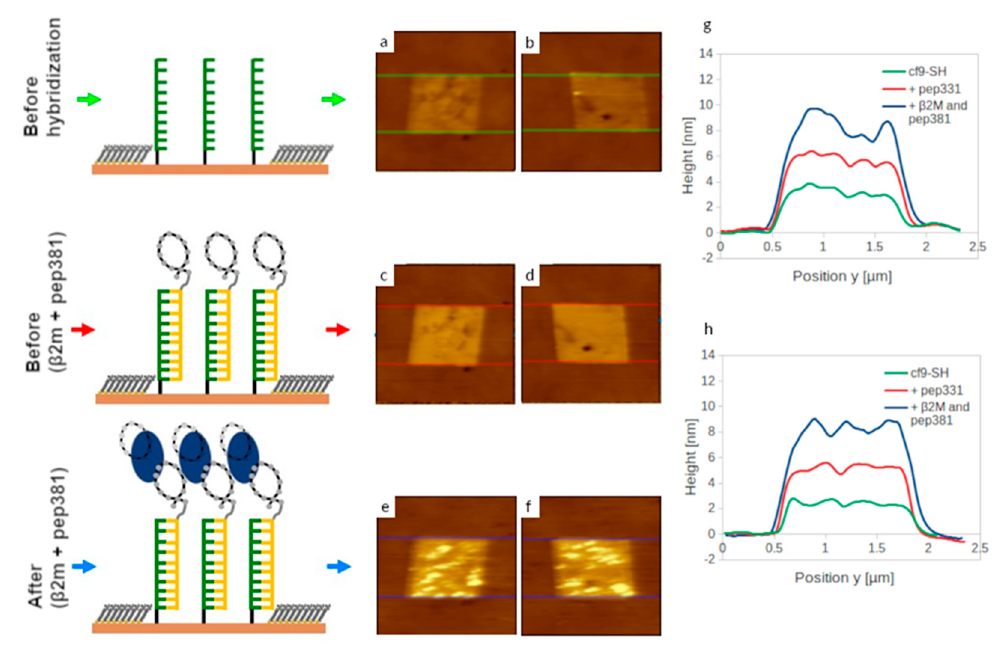
Figure 9. AFM detection of the ß2m/pep381 complex by dsDNA–pep331. From top to bottom: ( a , b ) AFM images of the ssDNA before hybridization as depicted in the left schematic from ( a ); ( c , d ) the same patches after incubation with 100 nM solution of the complementary ssDNA–pep331. The schematic to the left of ( c ) depicts the laterally confined dsDNA–pep331 molecules surrounded by the bioresistant TOEG monolayer. ( e , f ) show the same patches after incubation with the solution of the ß2m/pep381 complex and after an additional washing with TE buffer. The schematic to the left depicts the binding of the ß2m–pep381 complex by the laterally confined dsDNA–pep331 molecules. ( g ) Heights profiles of patches ( a , c , e ) averaged over the area between the corresponding lines. ( h ) Height profiles of patches ( b , d , f ) determined as in ( g ).